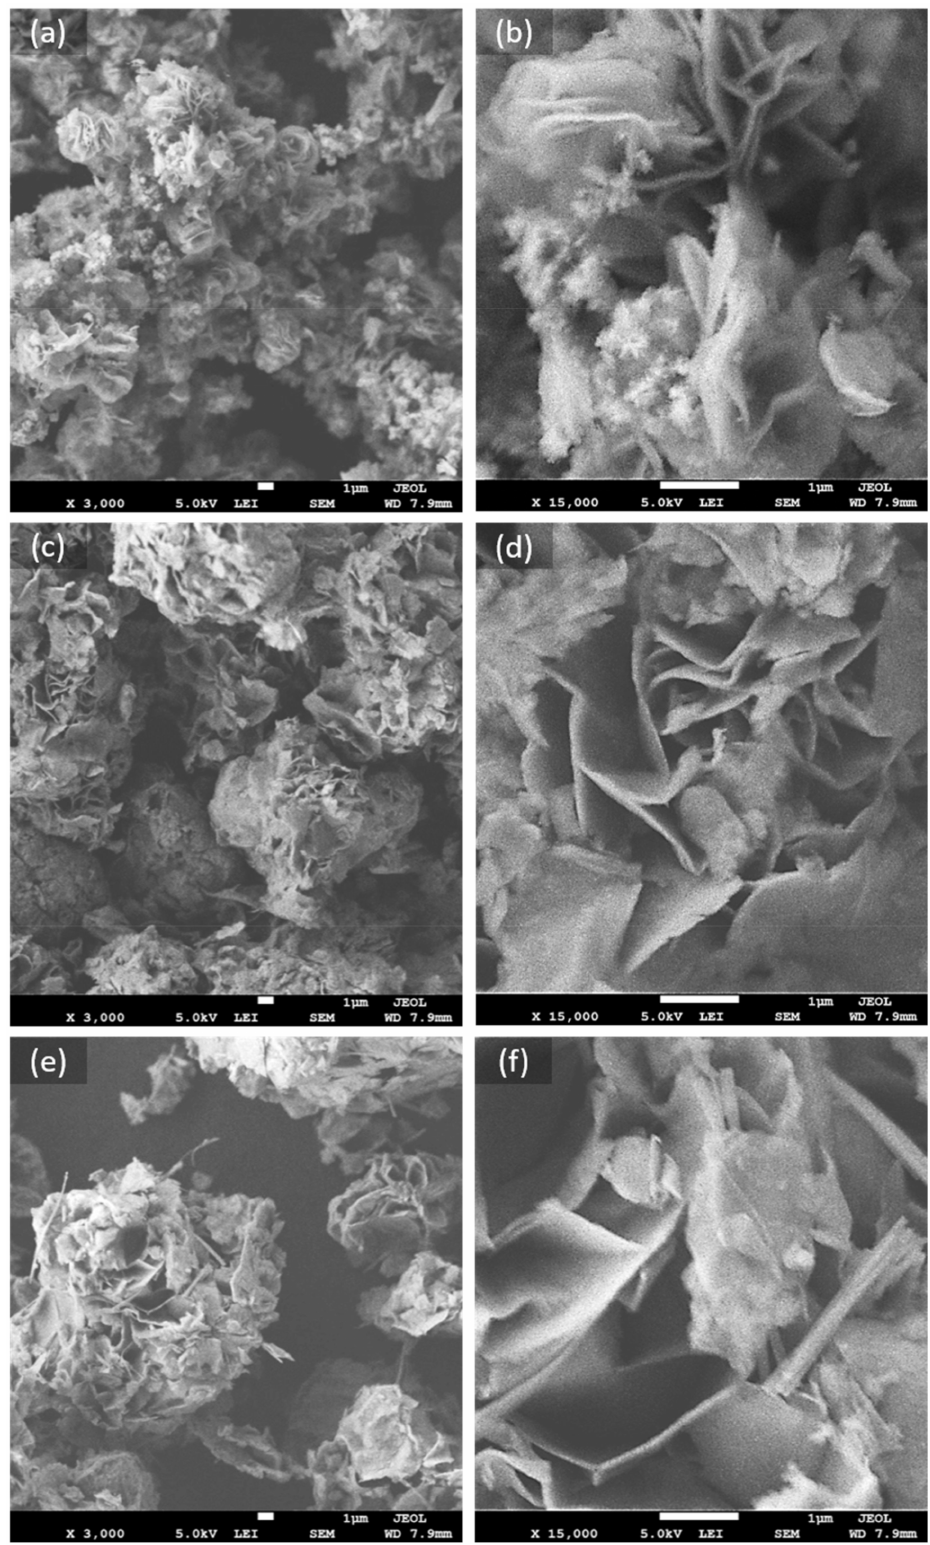
Figure 3. SEM images of ( a , b ) N.A.150C.30m, ( c , d ) N.A.220C.30m, and ( e , f ) N.A.220C.90m, at different